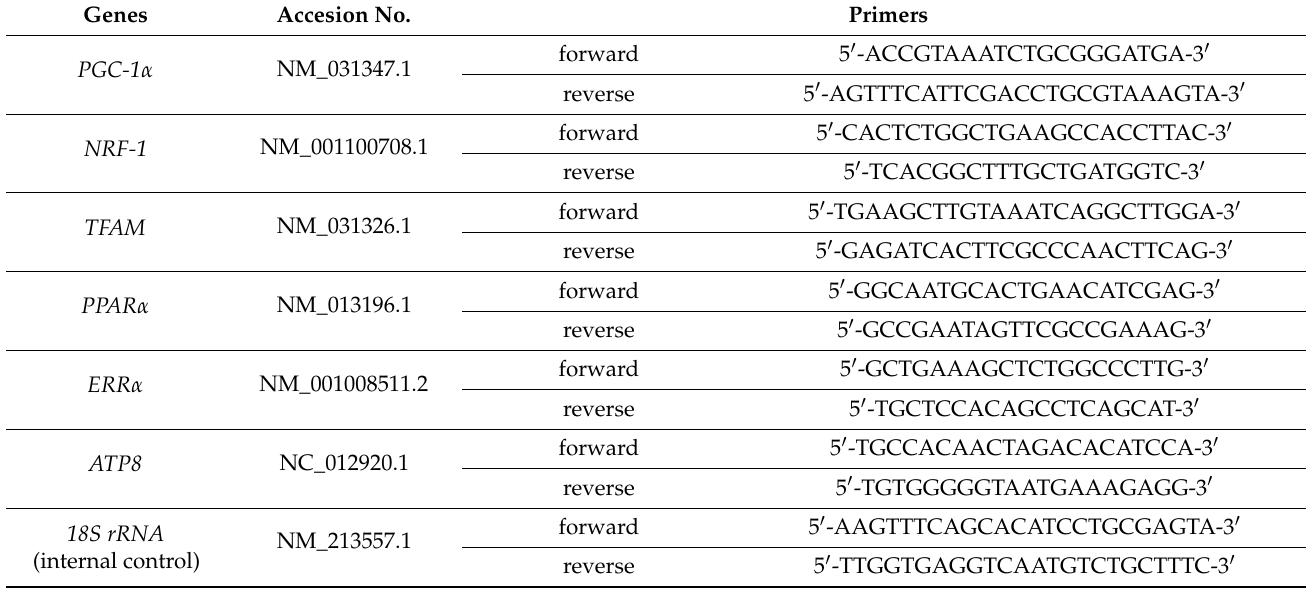
Table 1. Primer sequences.